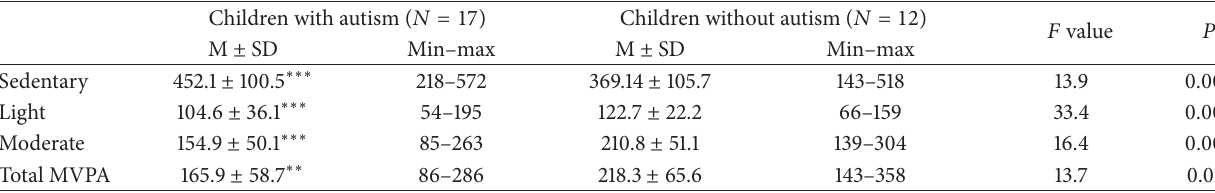
Table 3: Daily average time spent in physical activity by